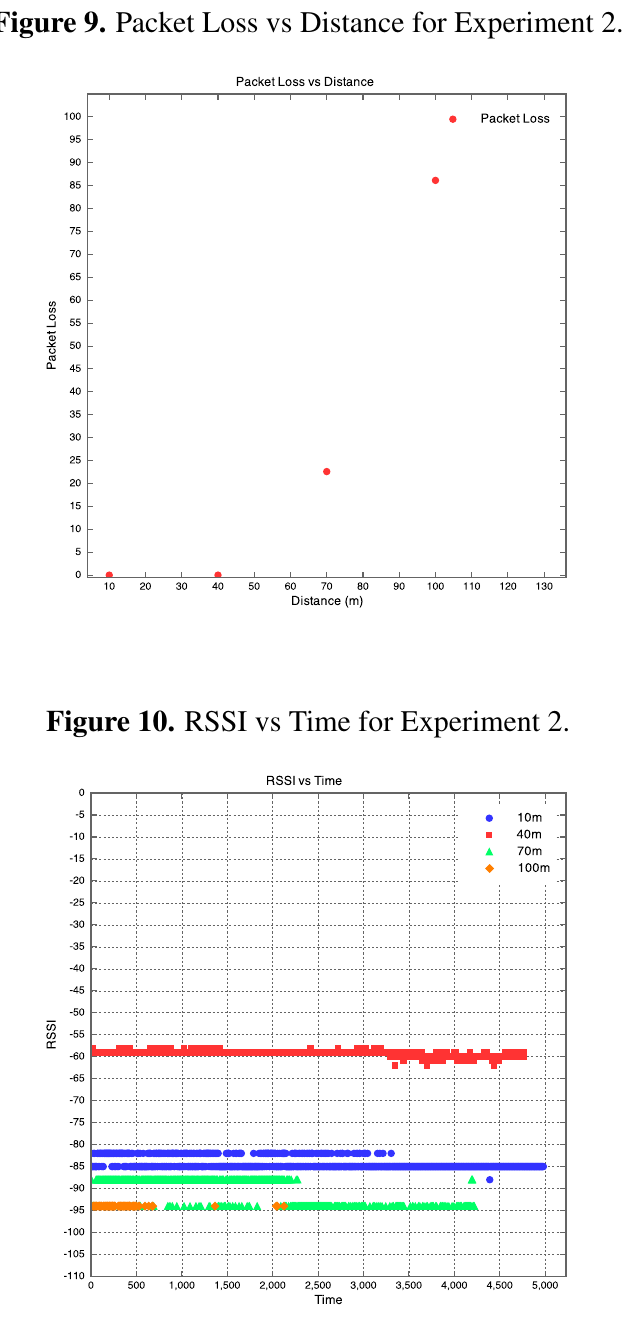
Figure 9. Packet Loss vs Distance for Experiment 2.